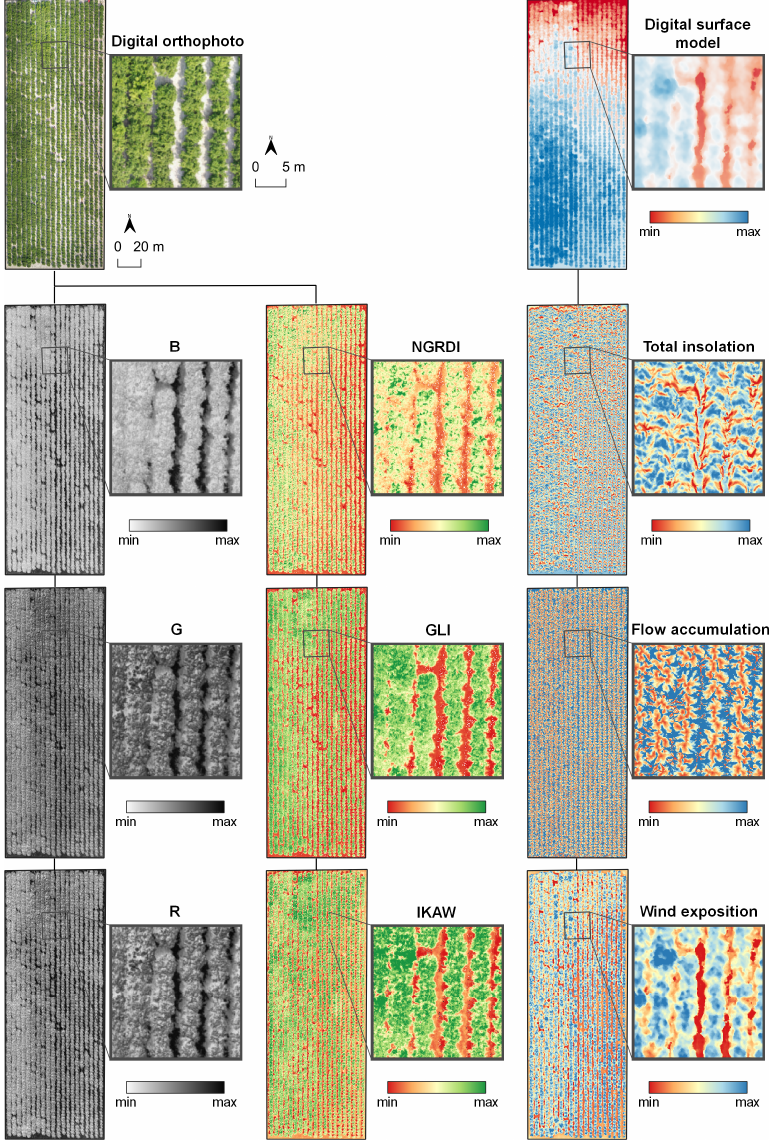
Figure 3. The display of input data used for the cropland suitability assessment from the digital orthophoto and digital surface model using low-cost UAV imaging.